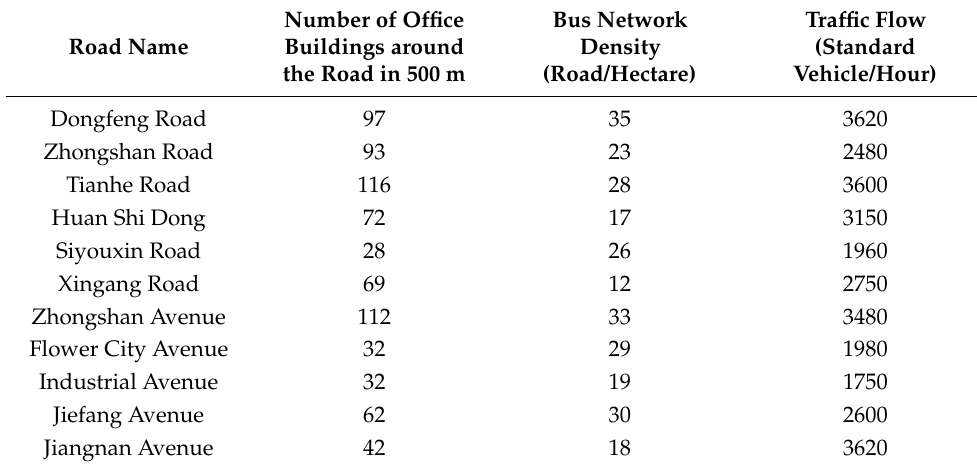
Table 5. Part of horizontal trunk roads.